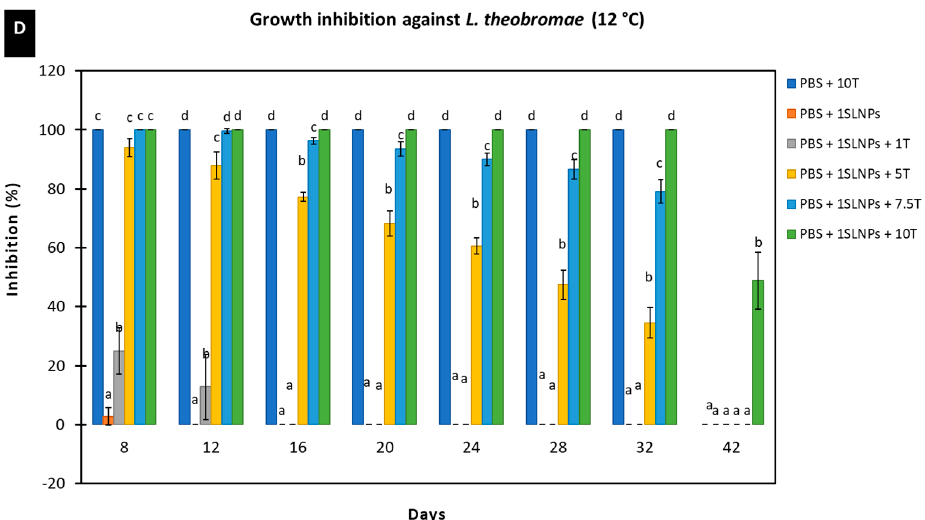
Figure 7. Growth inhibition of PBS composite films containing 1% SLNPs at 30 °C against ( A ) C. gloeosporioides and ( B ) L. theobromae ; at 12 °C against ( C ) C. gloeosporioides and ( D ) L. theobromae . Values are presented as mean ( n = 3) with the standard deviation represented by vertical bars. Means followed by the same letter between treatments per day are not significantly different at p ≤ 0.05 using DMRT.